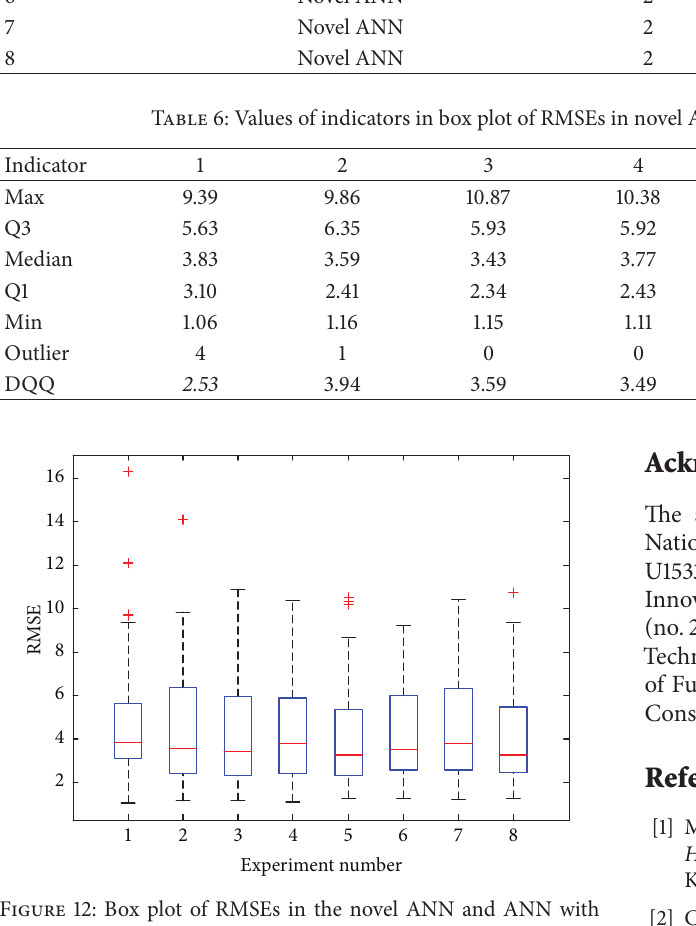
Figure 12: Box plot of RMSEs in the novel ANN and ANN with Bayesian